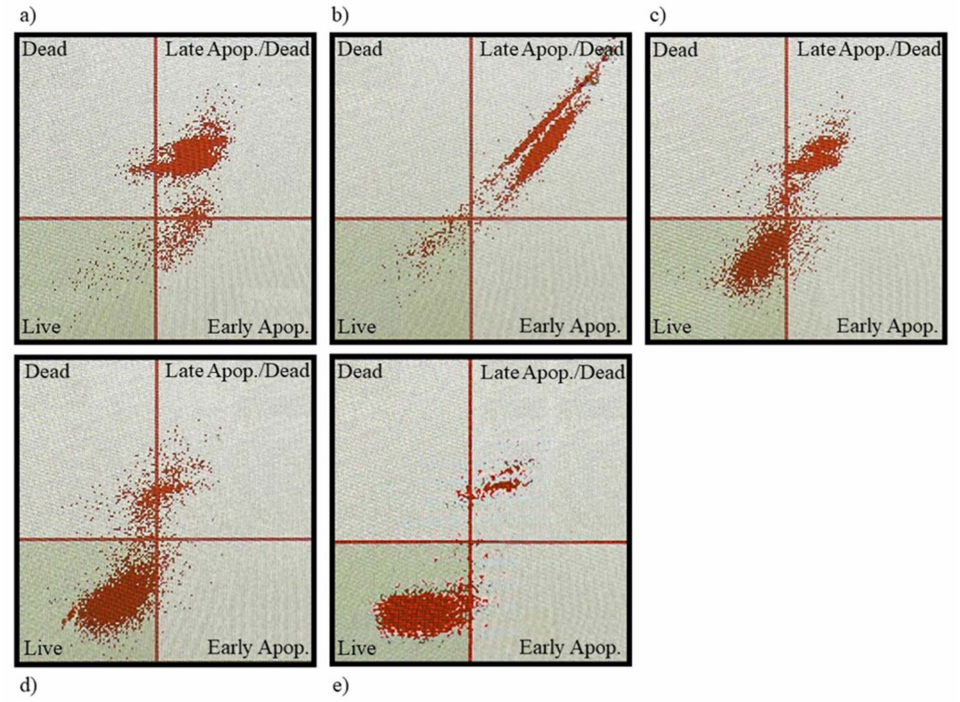
Figure 5. Annexin V/7-AAD staining in melanoma WM-266-4 cells. Cells treated with EC extract of concentration ( a ) 3 × 10 − 3 mg/mL, ( b ) 2 × 10 − 3 mg/mL, ( c ) 10 − 3 mg/mL, ( d ) 7 × 10 − 4 mg/mL and ( e ) untreated cells.